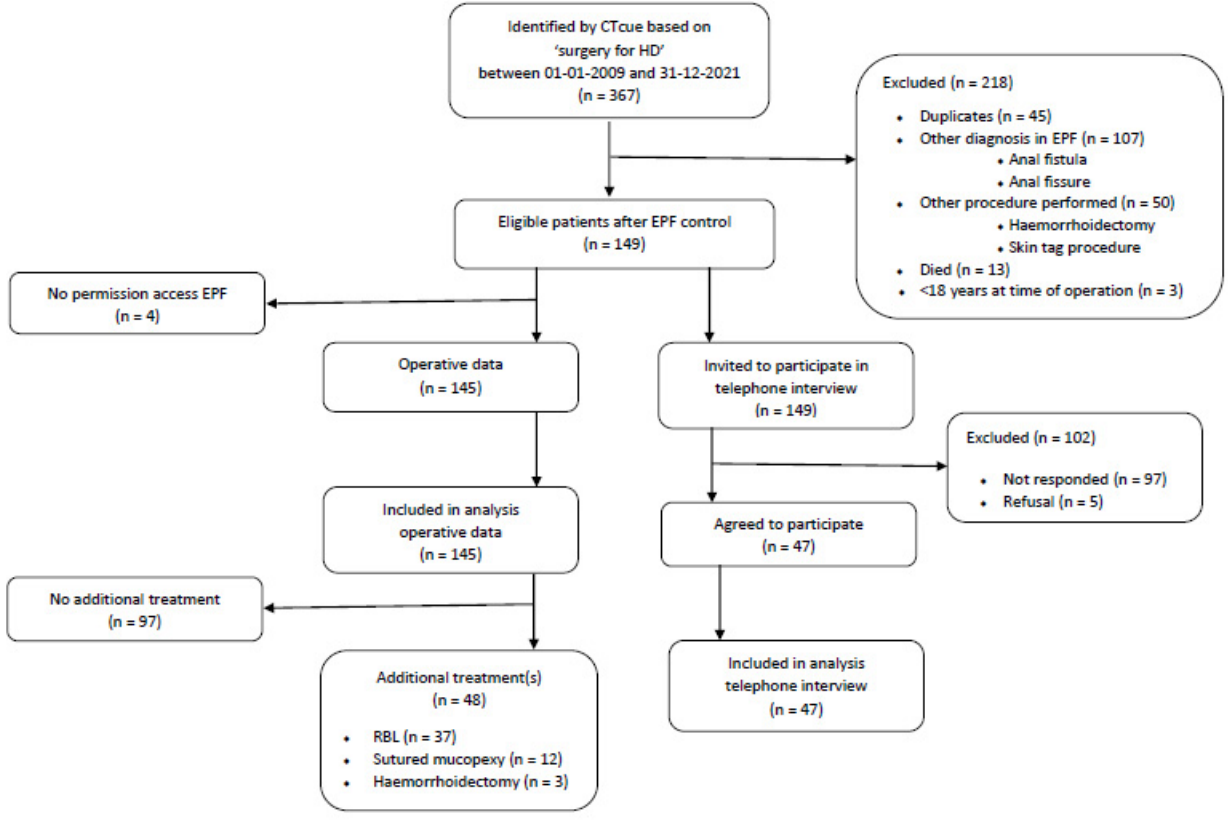
Figure 2. Flowchart of the participating patients.